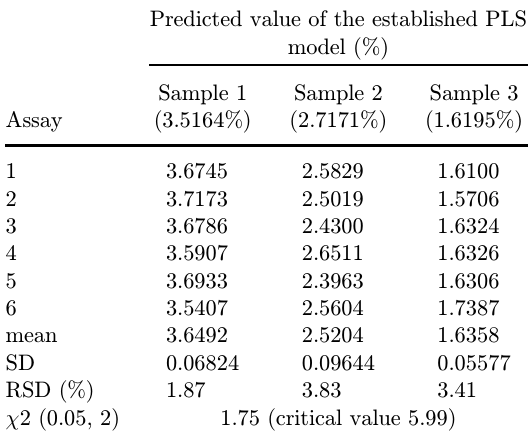
Table 6. Statistical results of precision.